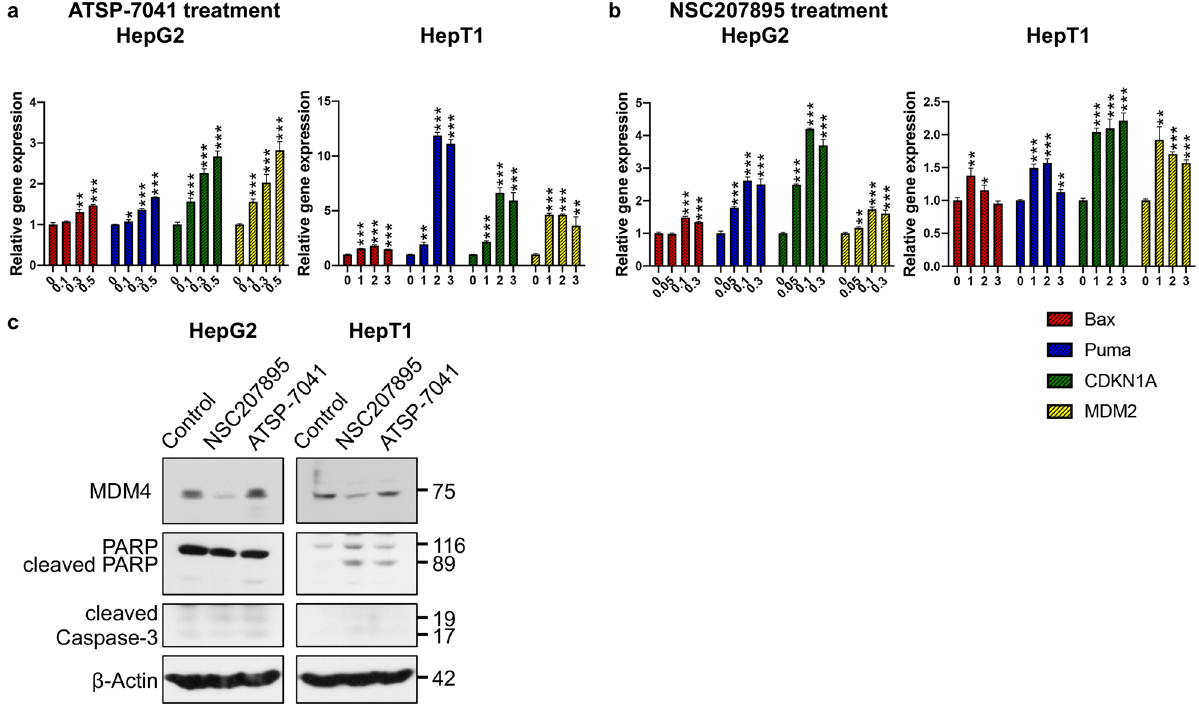
Figure 5. Prolonged MDM4 inhibition with ATSP-7041 and NSC207895 lead to upregulation of p53 activity and downstream signaling. ( a ) Bar graphs representing normalized mRNA expression of p53 targets Bax , Puma , CDKN1A , and MDM2 analyzed with qPCR experiments. RNA extracted from HepG2 and HepT1 cells treated with the indicated concentrations of ATSP-7041 for 48 h was compared to that from untreated cells (0 h). Error bars represent SD. Data shown are representative of at least three independent experiments performed with three replicate wells each time. Student’s t test (two tailed) * P < 0.05, ** P < 0.01, *** P < 0.001. ( b ) Bar graphs representing normalized mRNA expression of p53 targets Bax , Puma , CDKN1A , and MDM2 analyzed with qPCR experiments. RNA extracted from HepG2 and HepT1 cells treated with the indicated concentrations of NSC207895 for 48 h was compared to that from untreated cells (0 h). Error bars represent SD. Data shown are representative of at least three independent experiments performed with three replicate wells each time. Student’s t test (two tailed) * P < 0.05, ** P < 0.01, *** P < 0.001. ( c ) Protein lysis from cells treated with 0.5 μM ATSP-7041 or NSC207895 for 48 h were compared to untreated, control cells (0 h). Immunoblotting was done with the indicated antibodies, including MDM4 (04–1555, Millipore). β-Actin immunoblotting was used as a loading control. Data shown are representative of at least three independent experiments. Full length blots are presented in Supplementary Fig.